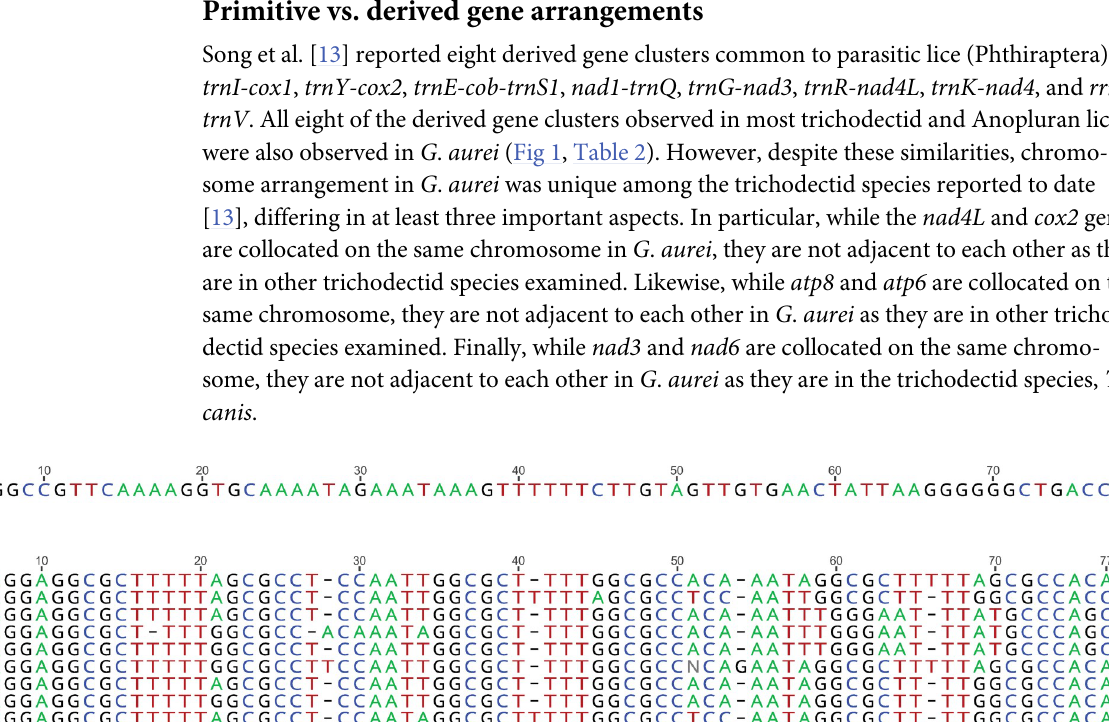
PLOS ONE | https://doi.org/10.1371/journal.pone.0254138 July 27,